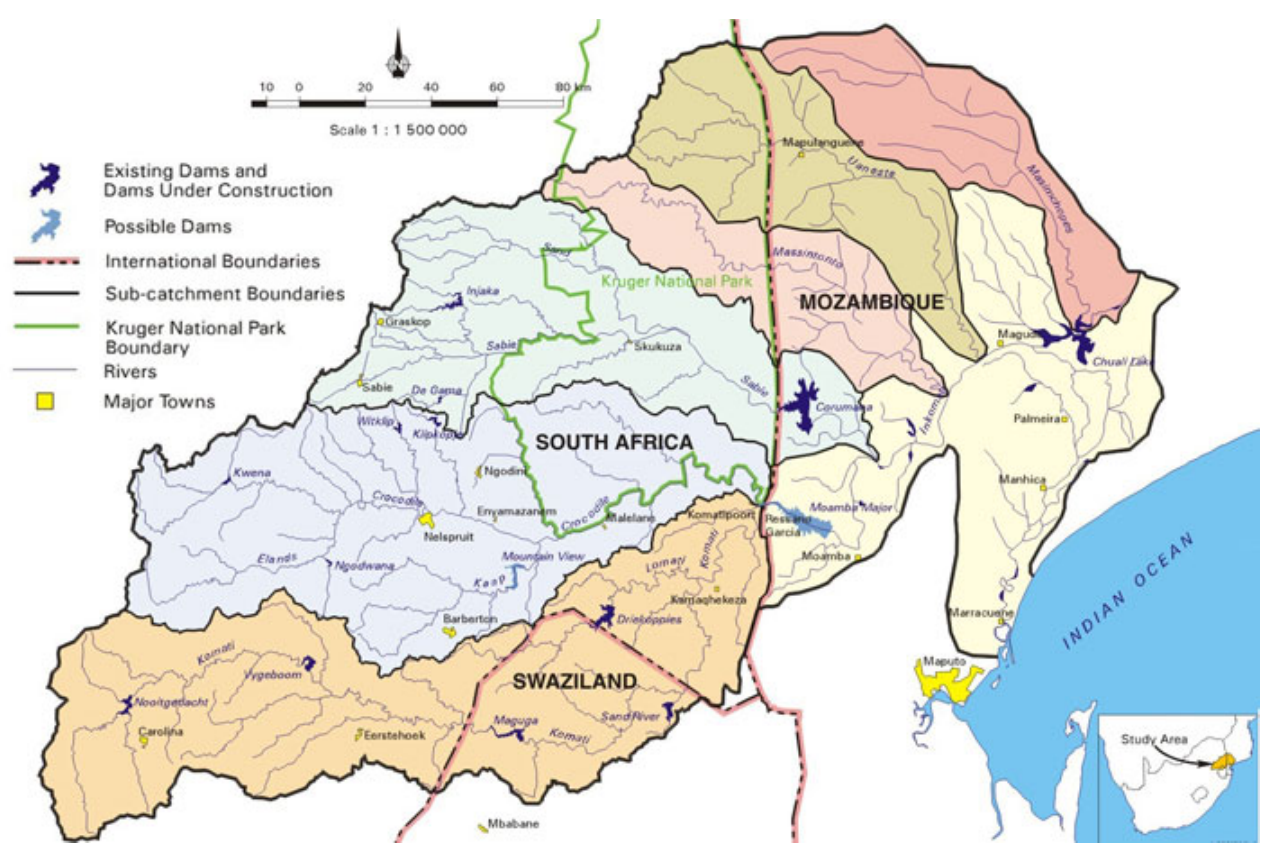
Figure 1. Map of the Incomati River Basin (after Consultec and BKS Acres